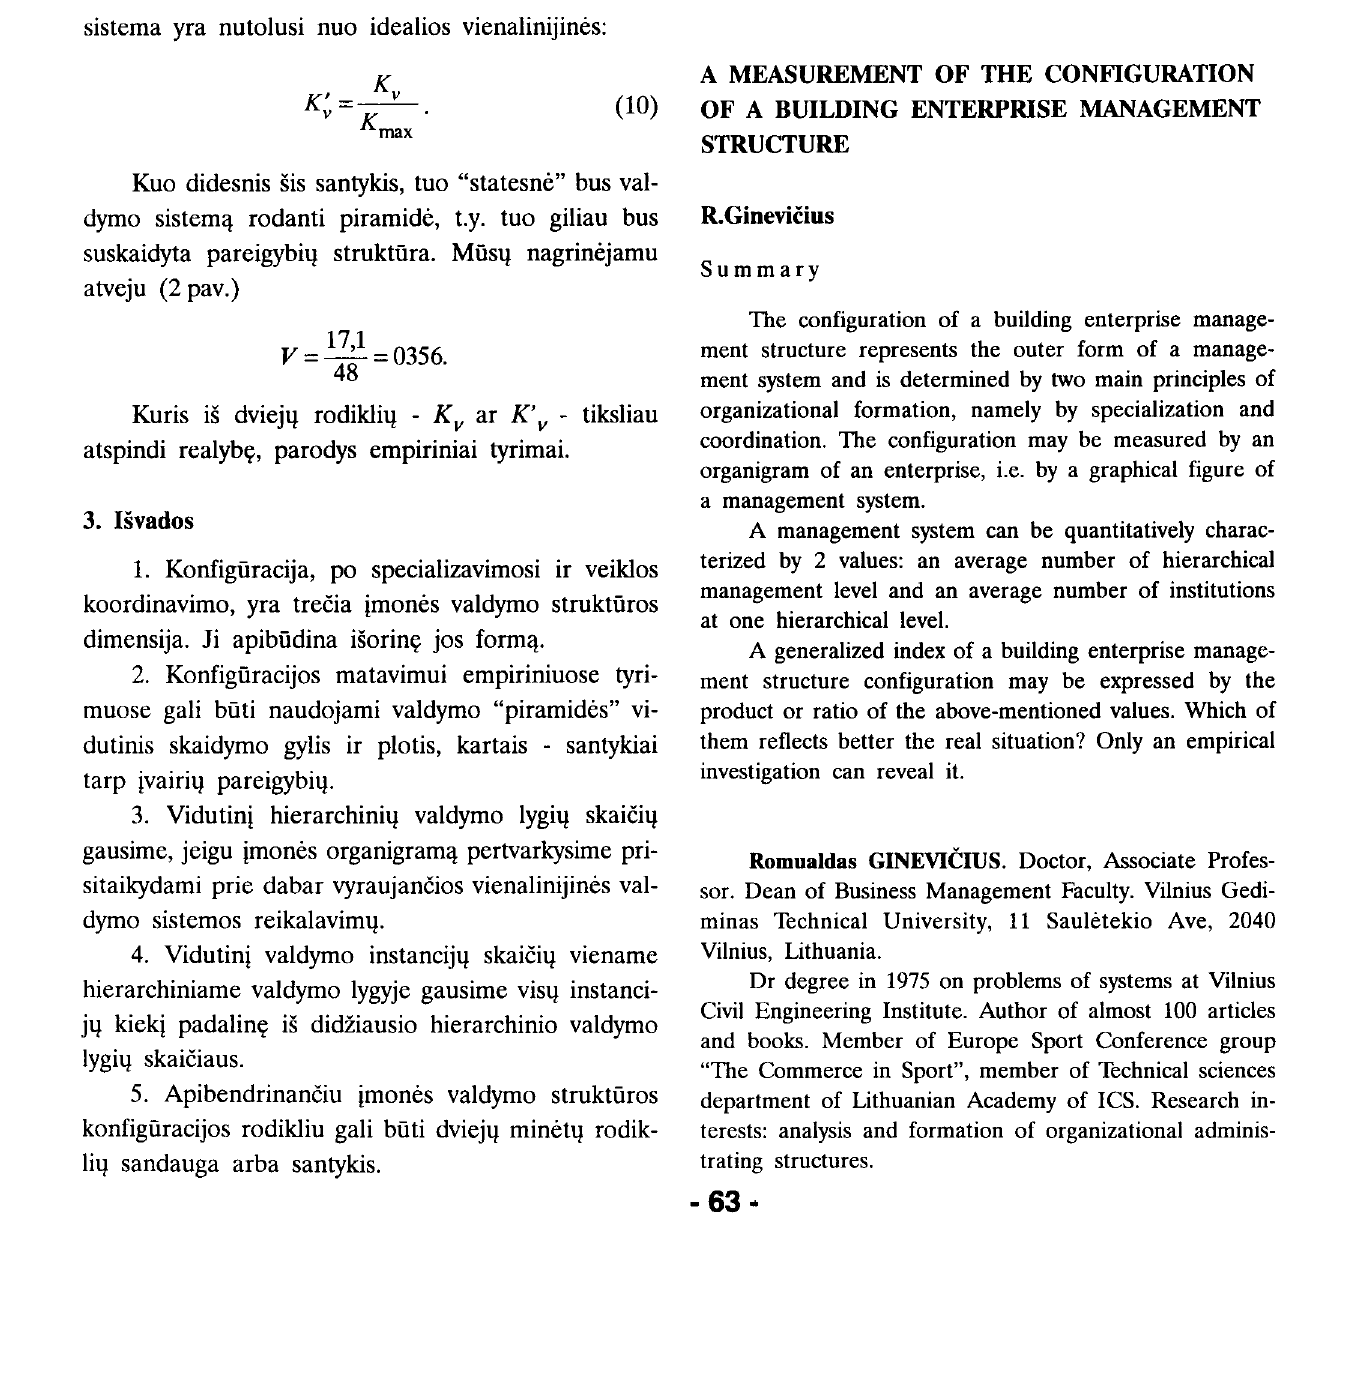
Fig. 3. Graphical interpretation of enterprise manage ment structural configuration index